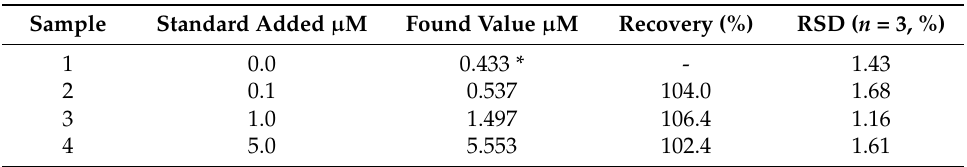
Table 3. Determination of ATP in serum samples.